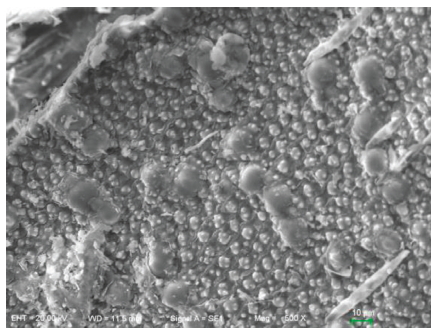
Figure 8: SEM images of wheat